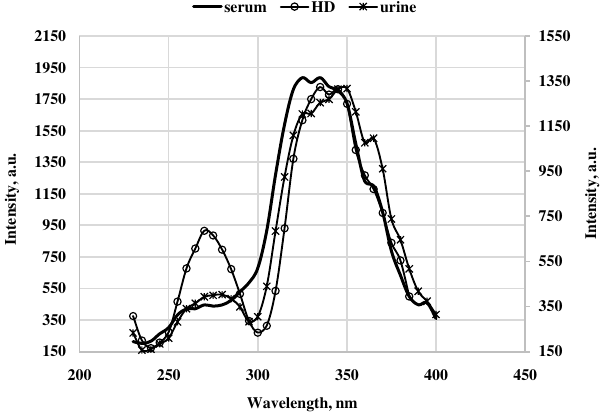
Fig. 2. Excitation spectra for (cid:1) em ¼ 430 nm in a CKD Pt's whole serum (the left intensity axis) and normalized spectra for whole urine (HC) and HD.